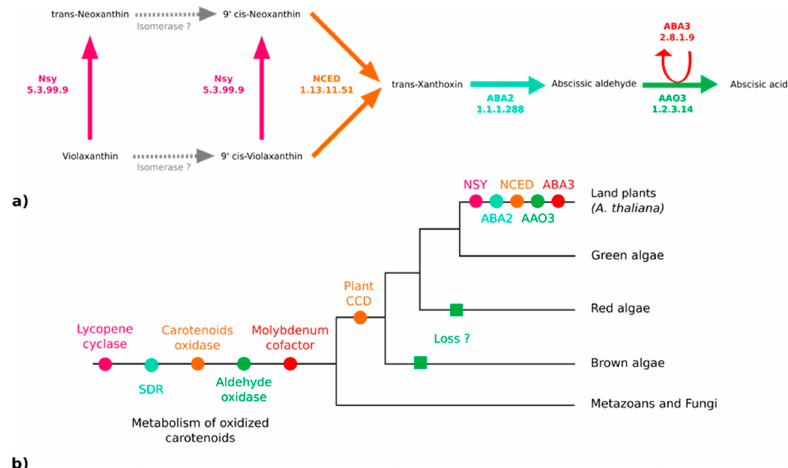
Figure 4. Enzymes of the abscisic acid biosynthesis pathway. ( a ) The ABA biosynthesis pathway in embryophytes ( A. thaliana ) [67]. ( b ) Phylogenetic tree representing the putative apparition and loss of the biosynthetic enzymes. NSY: Neoxanthin synthase; NCED: Abscisic – aldehyde oxidase; ABA2: Xanthoxin dehydrogenase; ABA3: Molybdenum cofactor sulfurase; AAO3: Abscisic – aldehyde oxidase; SDR: Short-chain alcohol dehydrogenase/reductase; CCD: Carotenoid cleavage dioxygenase.